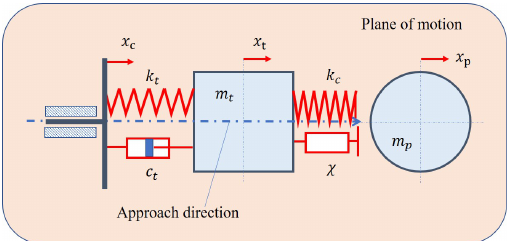
Figure 15. Model of the collision between a tool with decoupling elements and an